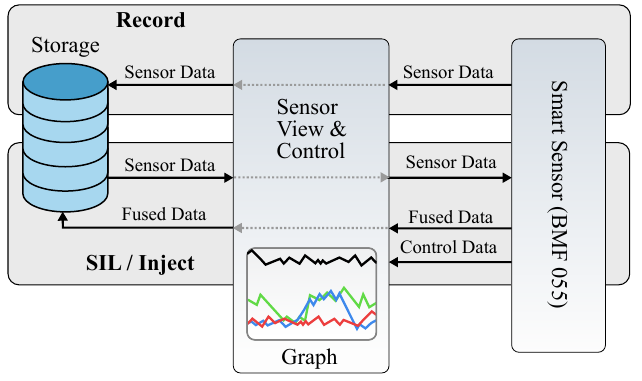
Figure 8. Data Flow of the SIL